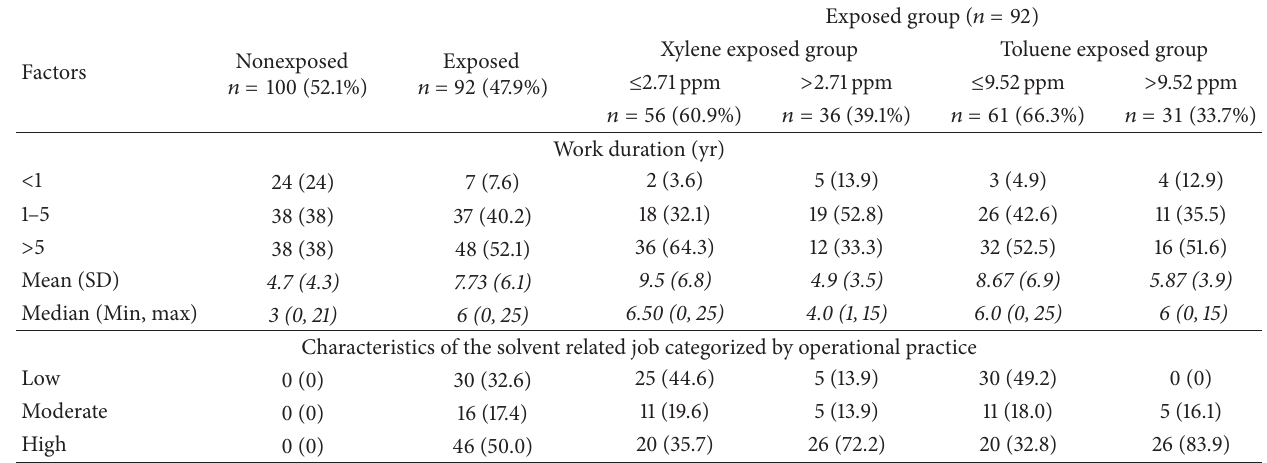
Table 2: Work history.